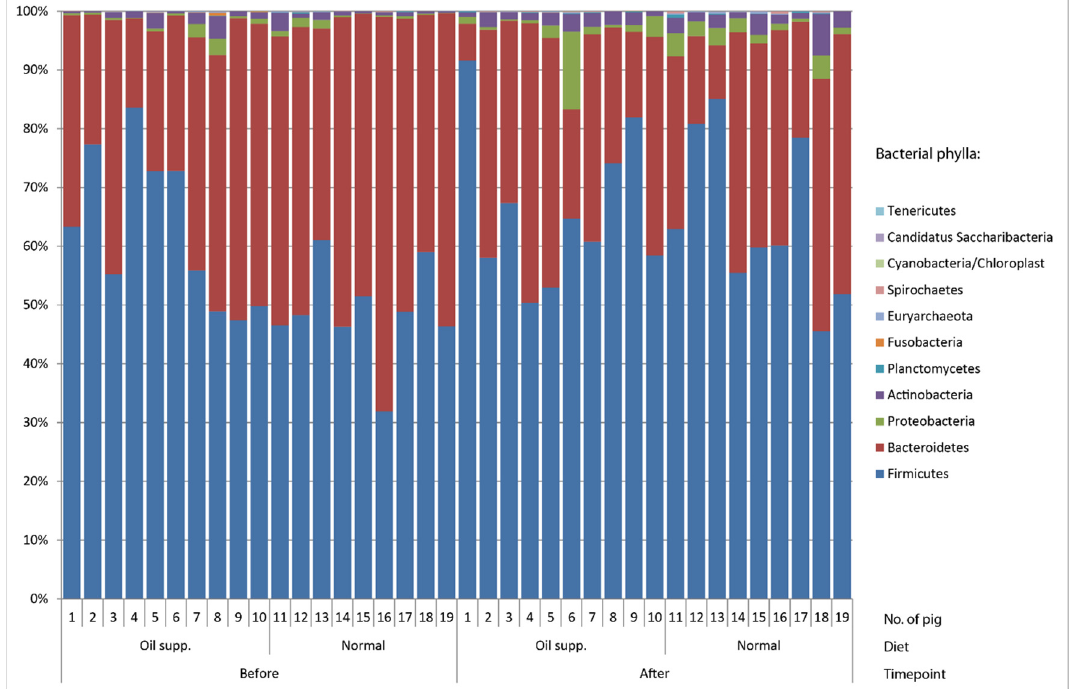
Figure 2. Bacterial phyla in the rectal swab of pigs fed a normal diet and a diet supplemented with coconut oil. Bacterial diversity expressed by Shannon’s index was not significantly di ff erent between groups either before or after treatment (ANOVA; F = 5.47; DF = 4; p = 0.458), but the variance within some